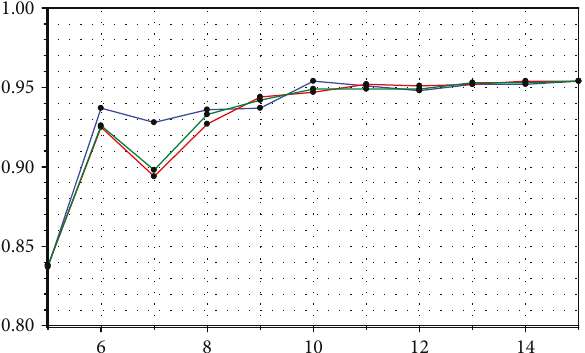
Figure 9: Blue: α k , S